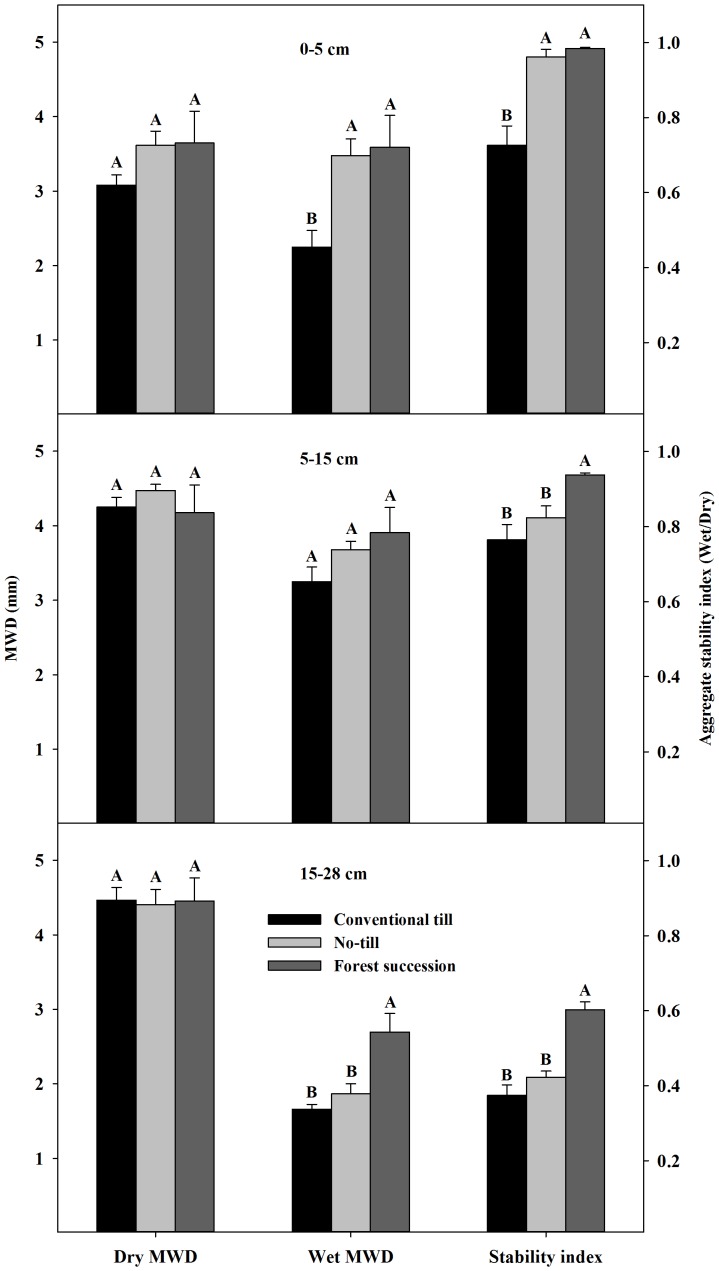
Dry-sieved and wet-sieved aggregates' mean weight diameter (MWD) (mean ± 1 SE) at the Horseshoe Bend Agroecosystem Experiment (n = 4), Athens, GA, USA, October 2007.The aggregate stability index is calculated by dividing the Wet MWD by the Dry MWD. Different letters indicate statistical significance between land uses within a depth class based on Tukey's HSD with a = 0.05. See also Table S1